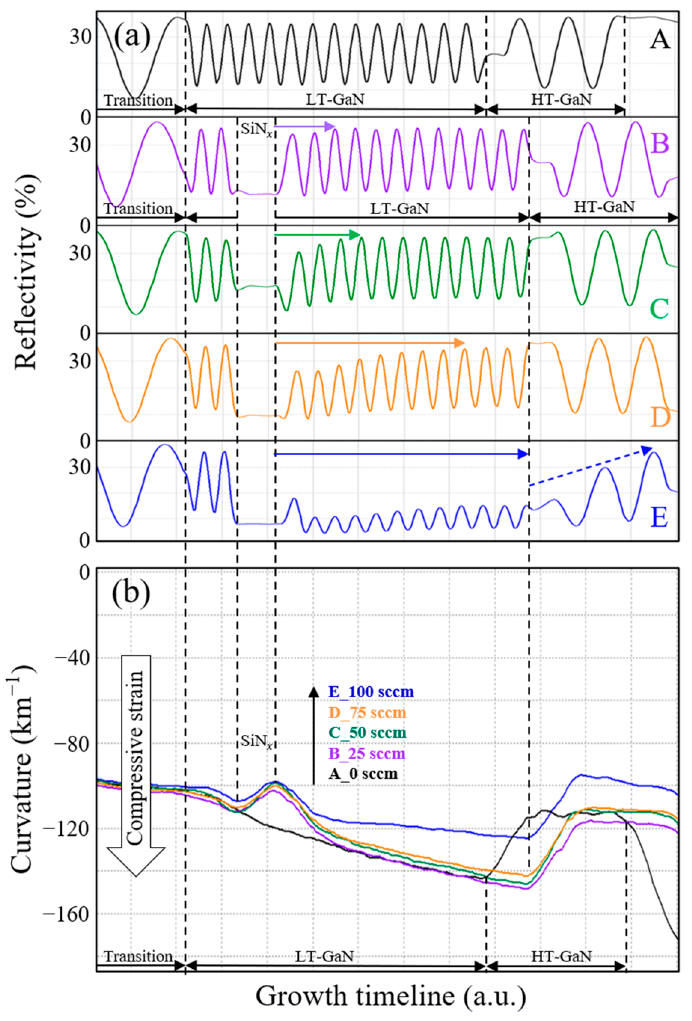
Figure 2. In situ ( a ) reflectivity and ( b ) curvature monitoring of sample surfaces.